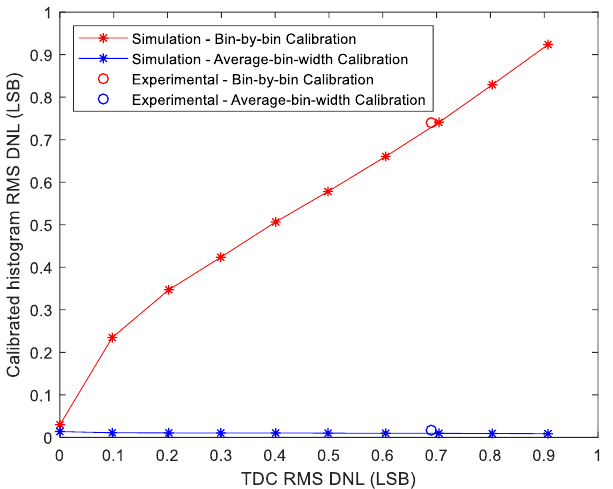
Figure 12. Simulation and experimental results for synchronous TDCs: the DNL after applying the calibration methods compared to the DNL of the raw TDC.